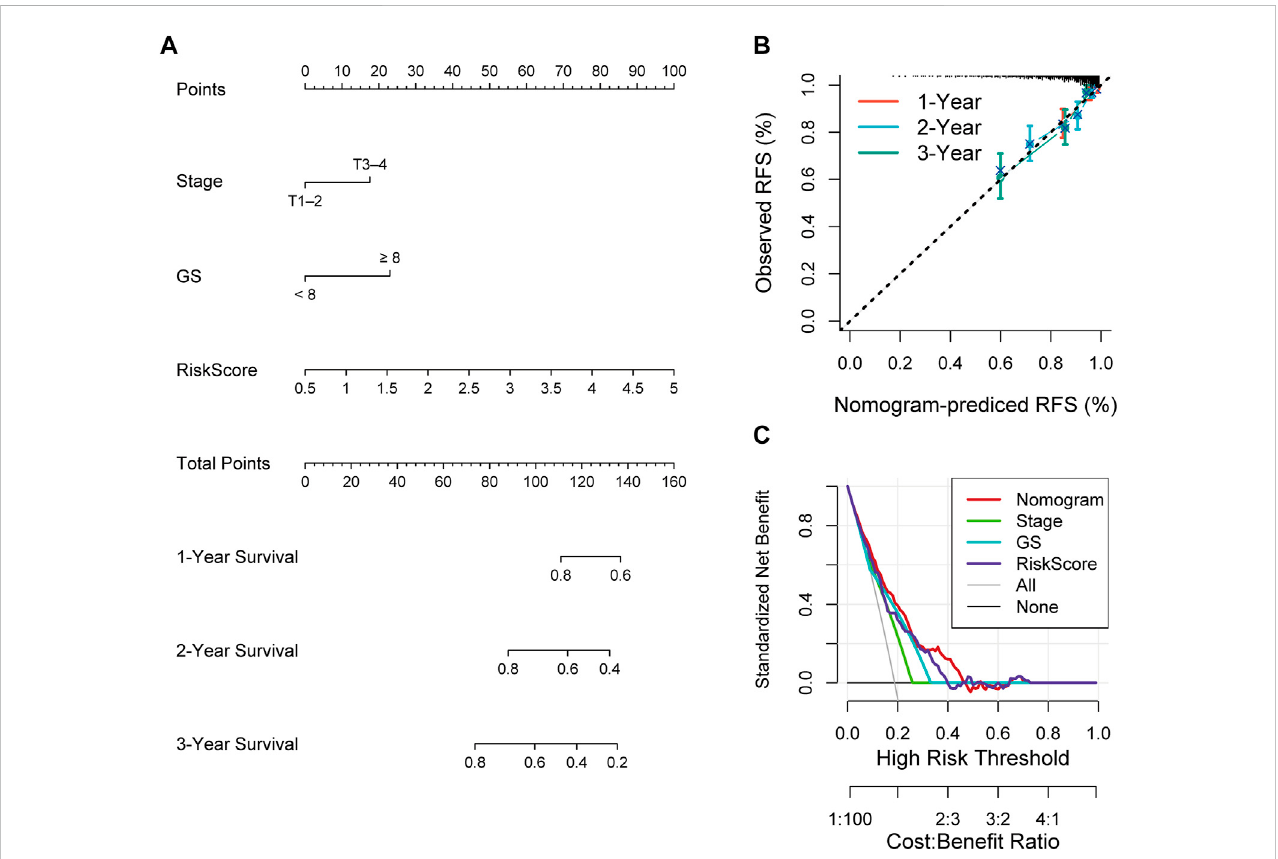
FIGURE 7 (A) Nomogram based on signature score, T-stage and GS predicting RFS of PCa patients from TCGA cohort. (B) The calibration curve of the nomogram. The y-axis is actual RFS and the x-axis is the nomogram-predicted RFS. (C) The Decision curve analysis (DCA) evaluating the clinical practicality of the